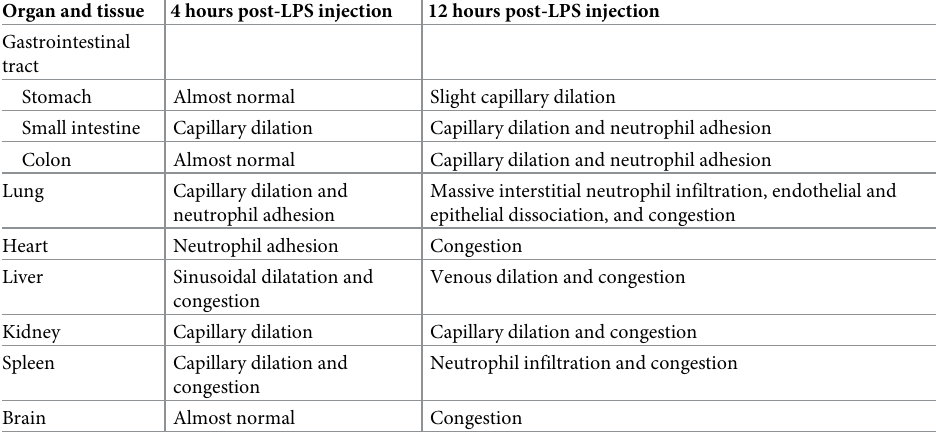
Acute interstitial inflammation in the lungs of both AD and WT mice In both WT and AD mice, a high number of neutrophils adhered to the endothelium of dilated interstitial capillaries around the pulmonary alveolus of the lung at 4 h post-LPS injection; these neutrophils were recruited to the interstitial spaces at 12 h post-LPS injection (Figs 3 and 4). To quantitatively compare alveolar inflammation between WT and AD mice (Fig 6A), we counted the number of neutrophils adhered to endothelium in the interstitial area at 12 h post-LPS challenge (Fig 6B). The mean number of neutrophils that adhered to the endothe- lium in the interstitial area was 6.58 ± 1.37 cells/capillary in WT mice and 6.95 ± 2.33 cells/cap- illary in AD mice at 12 h post-LPS challenge (Fig 6C). The mean circumference of dilated Table 3. Summary of histological findings in ASC-deficient mice after LPS